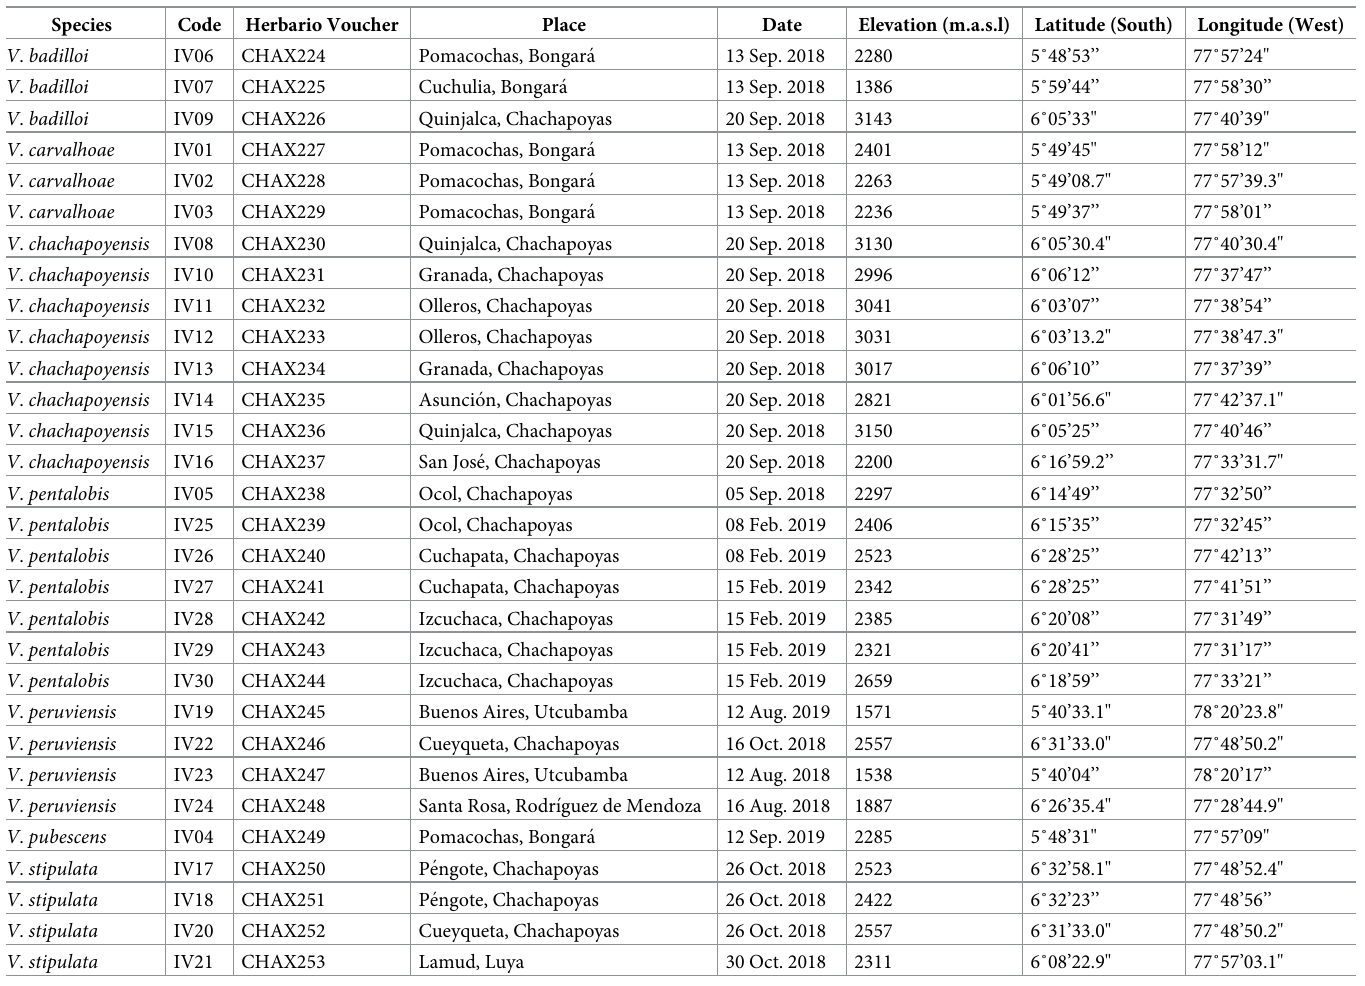
Table 1. List of samples of highland papayas collected in Region Amazonas, northern Peru. Species Code Herbario